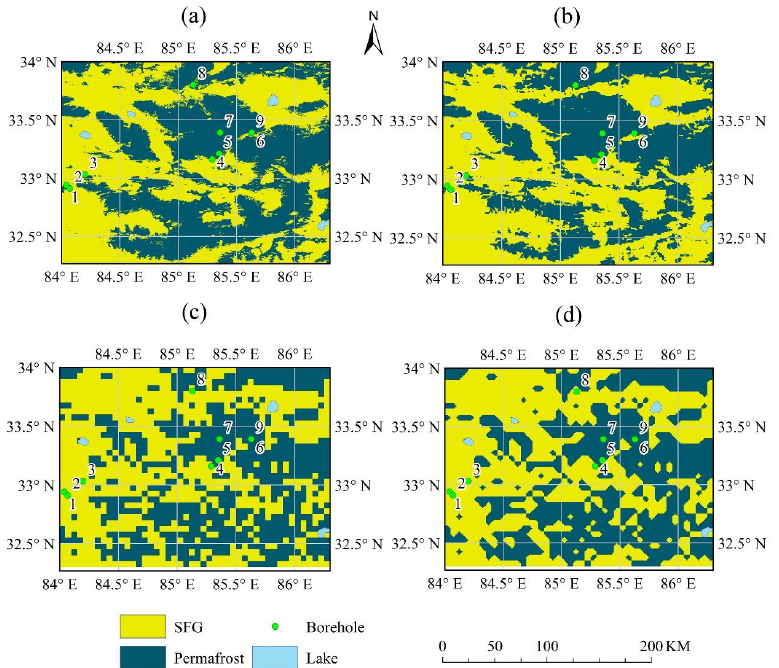
accounting for 48.3% of the total area, while SFG is 20.0 × 103 km 2 , accounting for 51.2% (Figure 2b). The Kappa coefficient for Figure 3b,d is 0.48, indicating that the two maps moderately agree with each other. The discrepancy of permafrost distribution in the two maps is 2.6% and mainly lies in areas with mixed vegetation cover, where the altitudinal limit of permafrost may be influenced by the distribution of vegetation coverage. Figure 9. ( a ) Permafrost types based on the MAGT and their distribution in the Gaize area; ( b ) ALT distribution map of the Gaize area (Borehole number 1 to 9 correspond to the borehole ID in Table 1).